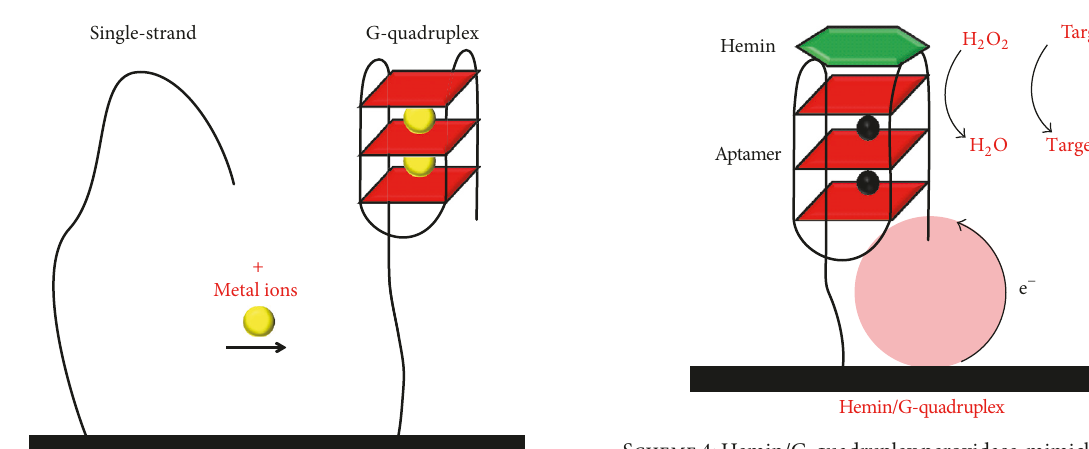
Scheme 4: Hemin/G-quadruplex peroxidase-mimicking DNAzyme operating